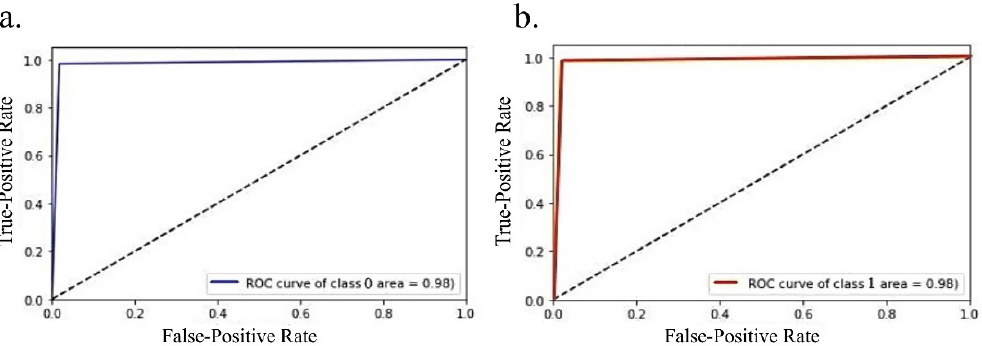
Figure 3. Receiver operating characteristics of the deep learning model where connectivity matrix was considered as an image for LGG (shown in ( a )) and HGG (shown in ( b )), the area under curve (AUC) score for both classes were 0.98. The above plot was obtained using Python sklearn package.